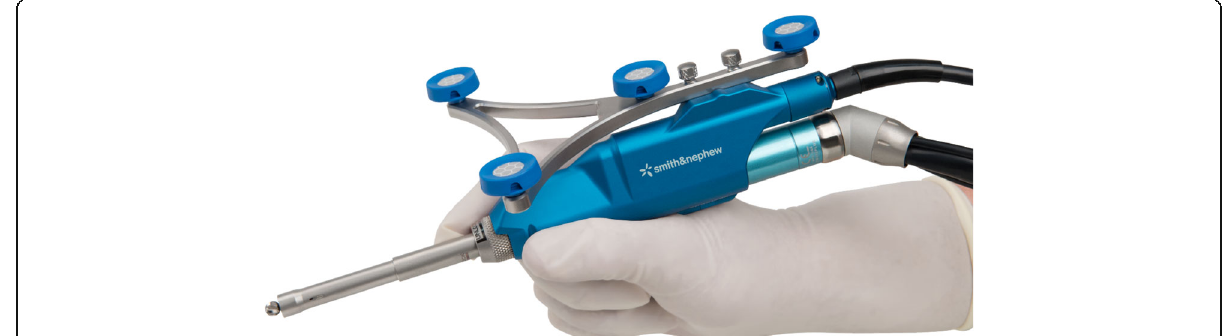
Fig. 3 Cutting burr connected to the robotic unit in image 2. The handpiece delivers the surgical plan determined by the surgeon. Whilst the surgeon still has some control over the movement of the cutting tool, some robotic systems are designed to ‘ cut-out ’ when the instrument strays from planned surgical resection margins on the plan